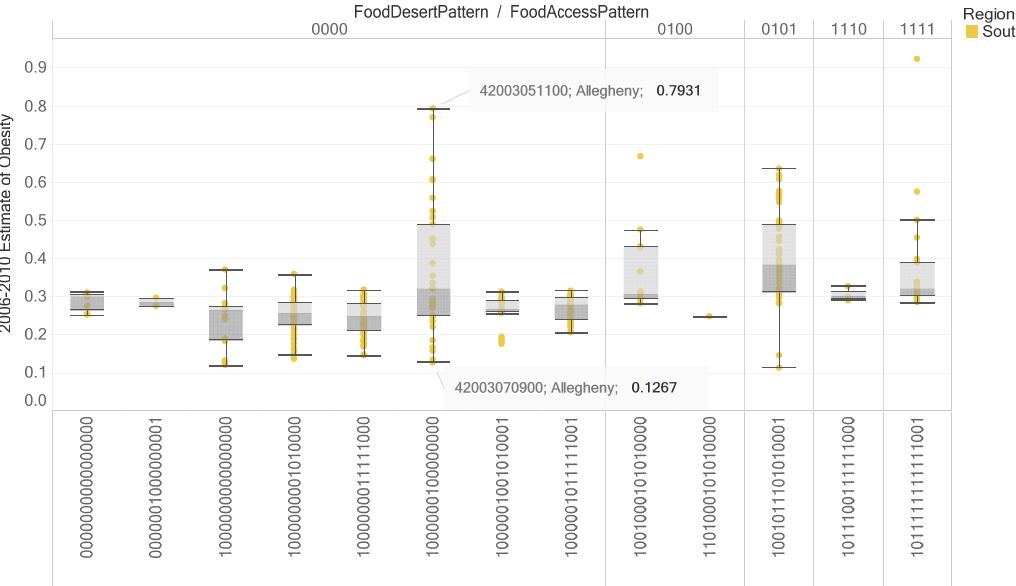
Figure 11. Regional comparison of estimates of obesity rates (2006–2010) for census tracts with the same food access pattern in Philadelphia County, Southeast Pennsylvania. We designed the box plot to support decisions on differences in obesity rates in a county (attention and motivation functions of knowledge visualization). The design of the view allows one or more counties to be selected (elaboration function of the knowledge visualization).